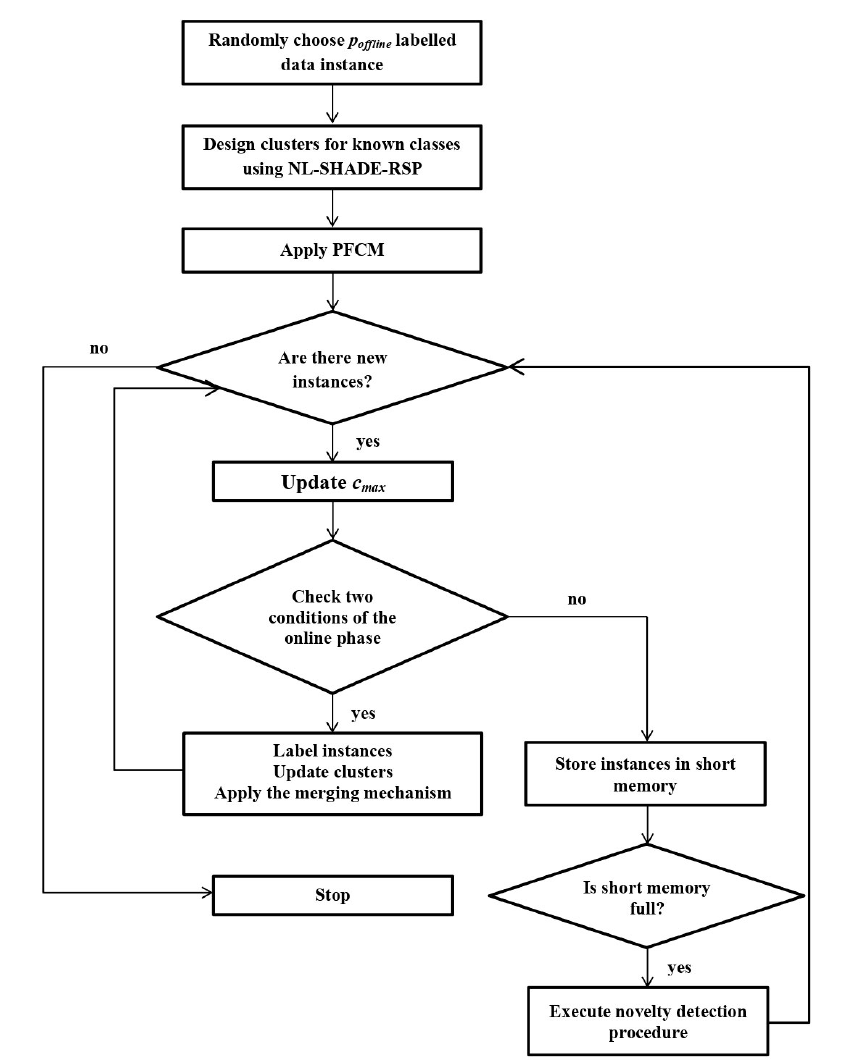
Figure 1. The general scheme of the HPFuzzNDA